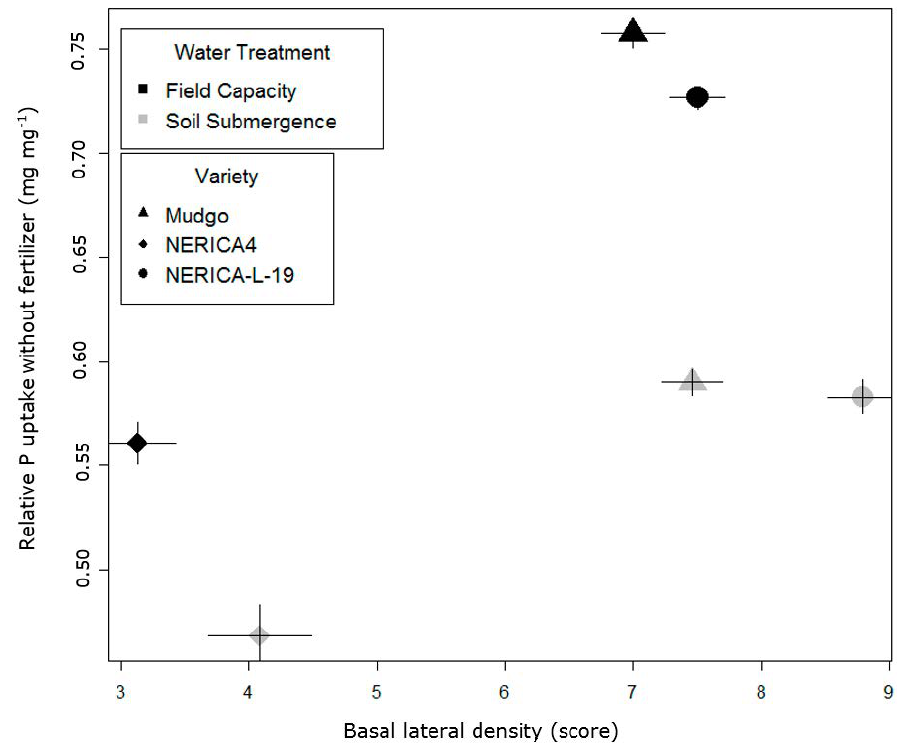
Figure 4. Relative P uptake of different rice varieties (i.e., the P uptake without P fertilization relative to the P uptake when P is sufficiently available) in relation to the observed basal lateral density (analyzed at 51 DAS). Three varieties (NERICA4, Mudgo, and NERICA-L-19) were grown on a lowland rice field with (30 kg P ha − 1 ) and without (0 kg P ha − 1 ) P fertilization and they were subjected to two water treatments (soil submergence versus field capacity). The higher basal lateral branching density relates with the low P tolerance of contrasting varieties and reduced water availability additionally enhances this relative P uptake.